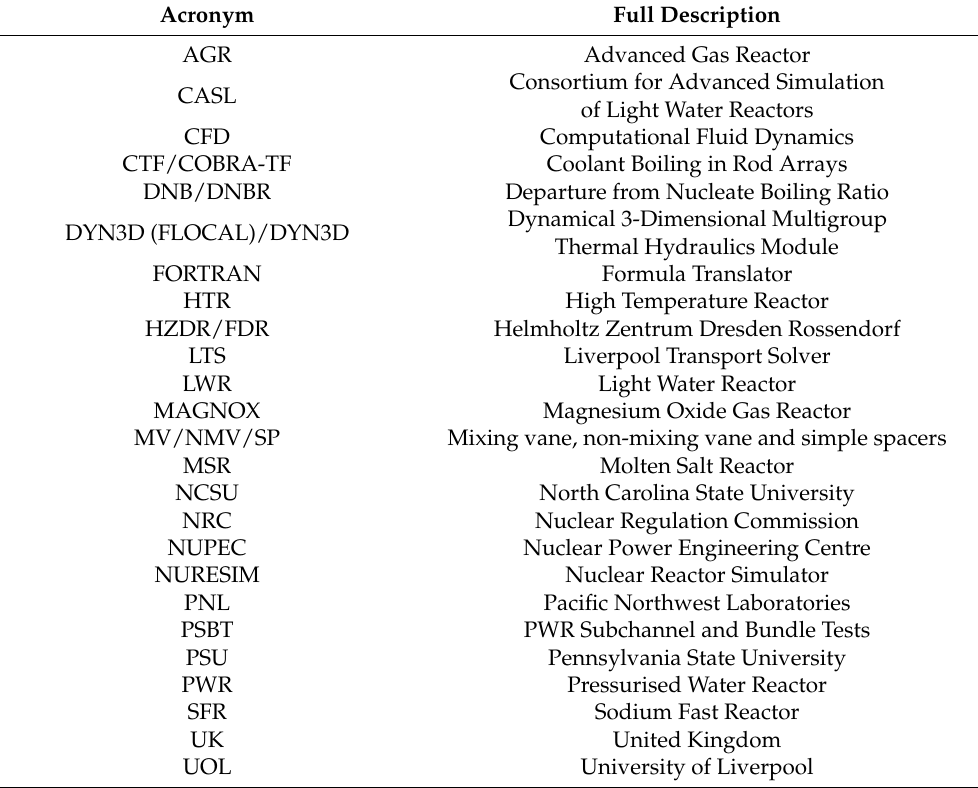
Table 10. Acronyms.